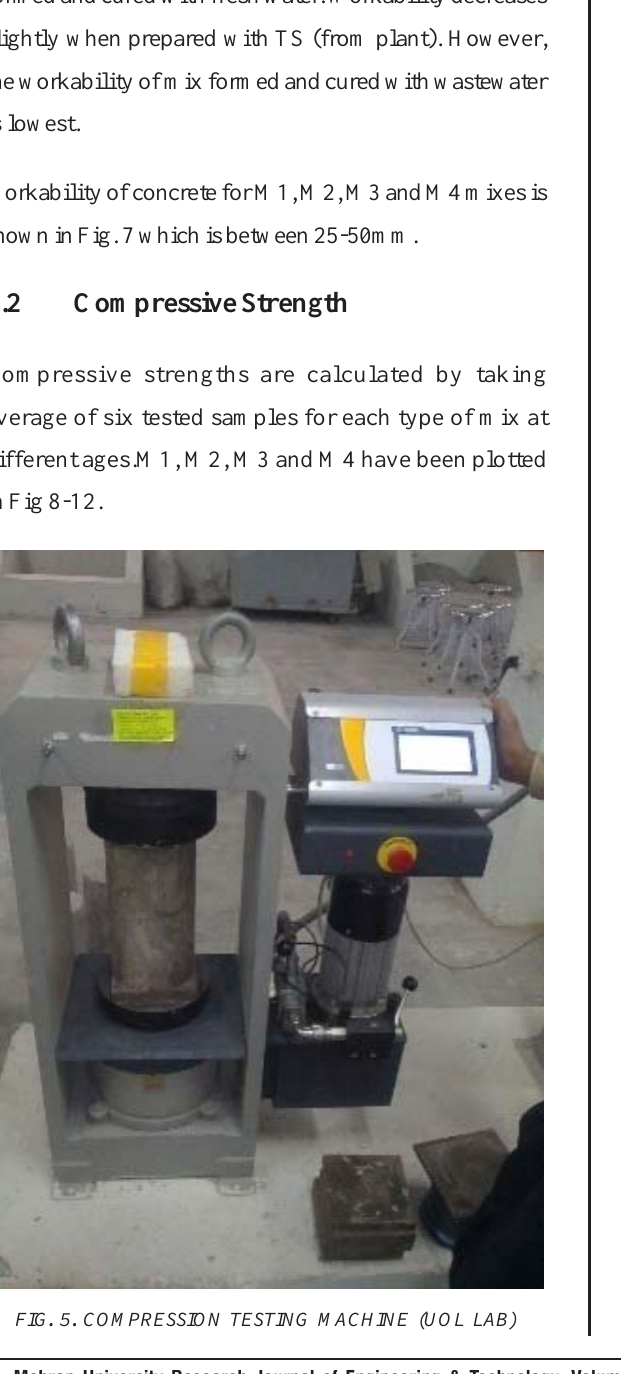
FIG. 5. COMPRESSION TESTING MACHINE (UOL LAB)